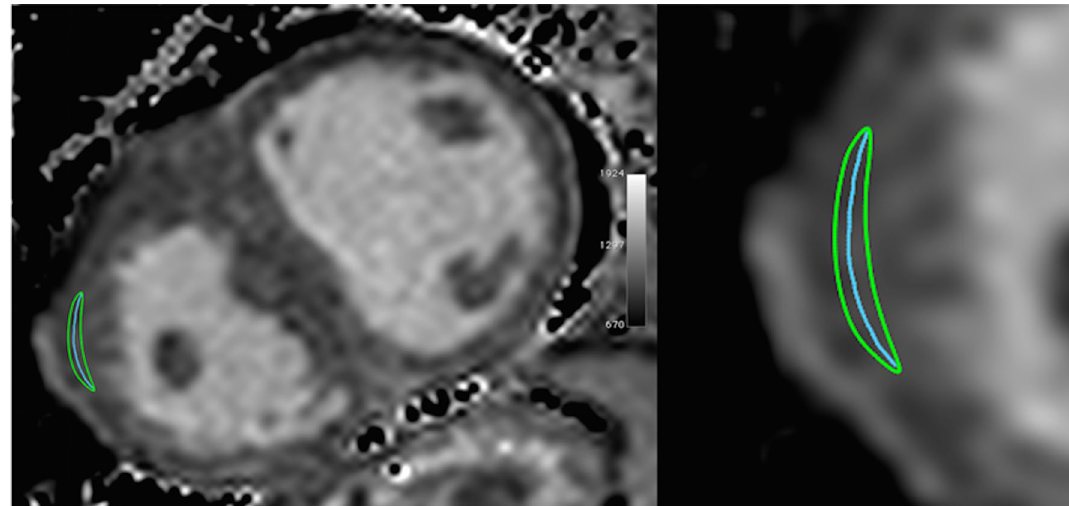
Figure 3. Example of T1 map in congenital heart disease. Representative native T1 map of a 47-year-old patient with palliated pulmonary atresia and ventricular septal defect showing region of interest (green) and corresponding line of interest (blue) in the right ventricle in short axis orientation. Images were created using OsiriX Lite (v.8.5, https ://www.osiri x-viewe r.com/).